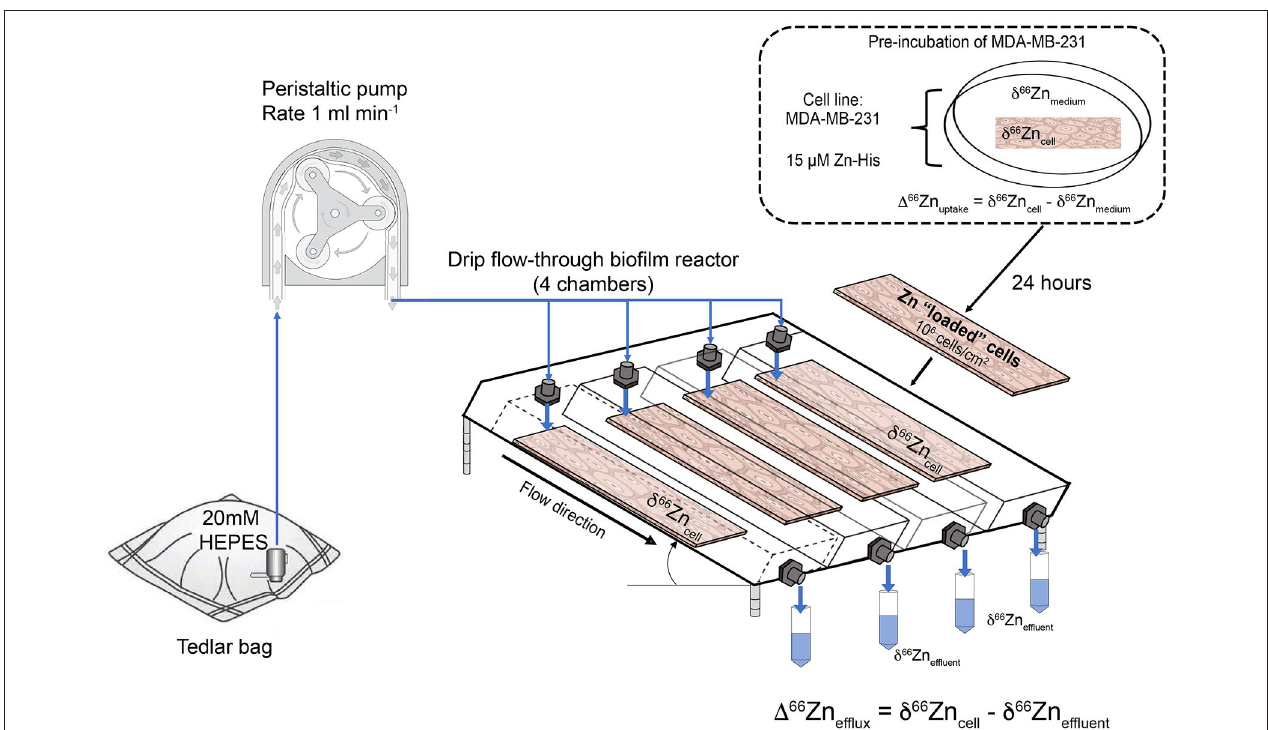
FIGURE 2 | Schematic of the cell uptake-efflux experiment. A HEPES solution from the Tedlar bags is pumped to the drip flow-through reactor (1ml min − 1 , as controlled by a peristaltic pump). The drip flow-through reactor contains 4 microscopic slides with MDA-MB-231 cells pre-grown in medium spiked with 15 µ M Zn-histidine (Zn-His). Effluent samples were taken for 0.5h in metal-free 50mL centrifuge tubes.